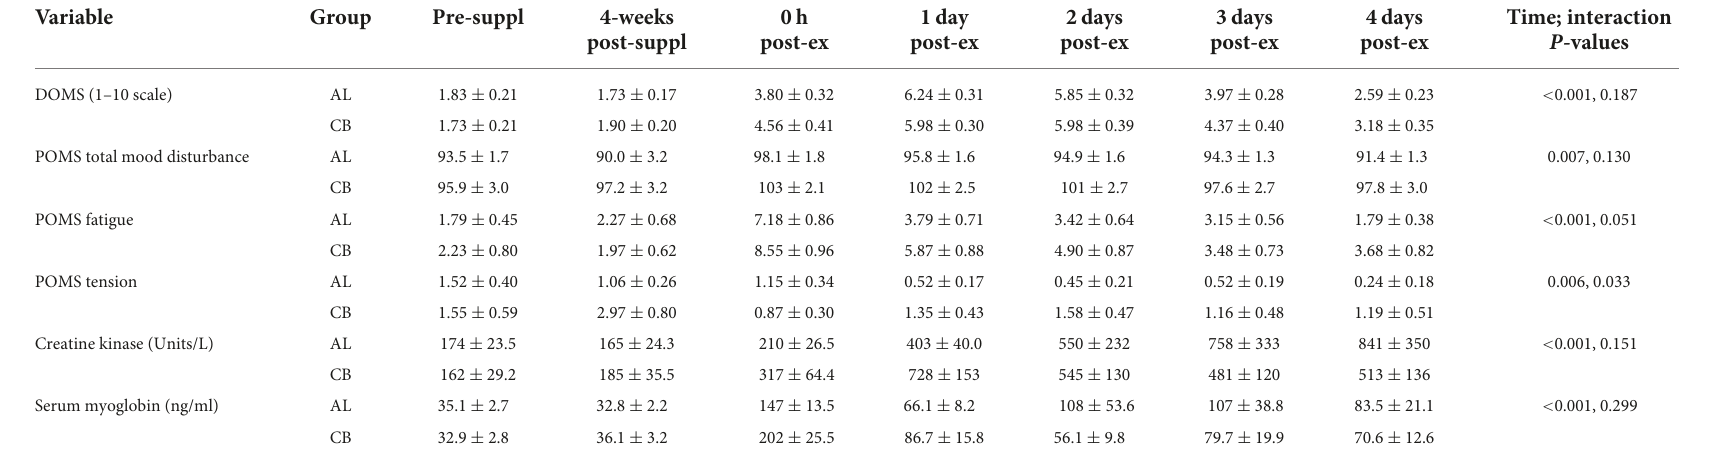
TABLE 4 Delayed onset of muscle soreness (DOMS), and muscle damage data before and after 4-weeks supplementation, and immediately post 90 min eccentric exercise and in an overnight fasted state during 4 days of recovery (AL = almond, n = 33; CB = cereal bar, n = 31) (means ±